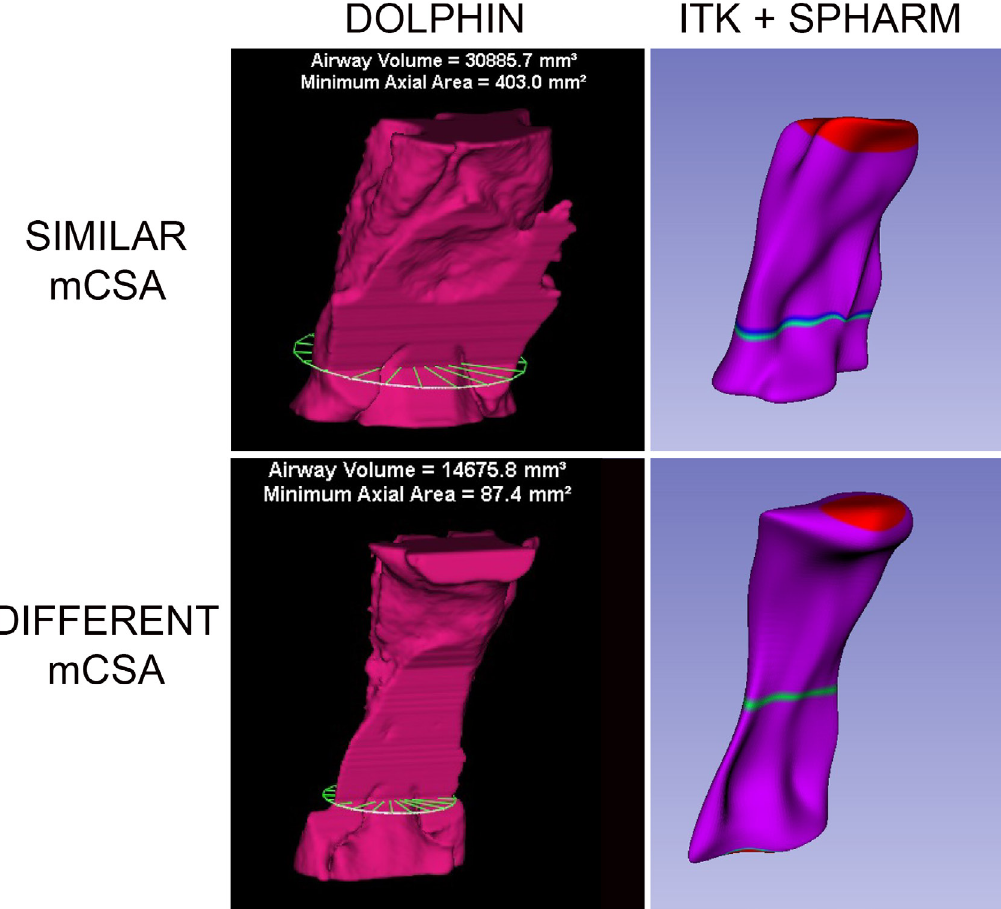
Figure 4- Models with similar and different position of the mCSA between segmentations performed in Dolphin3D (left) and ITK-Snap